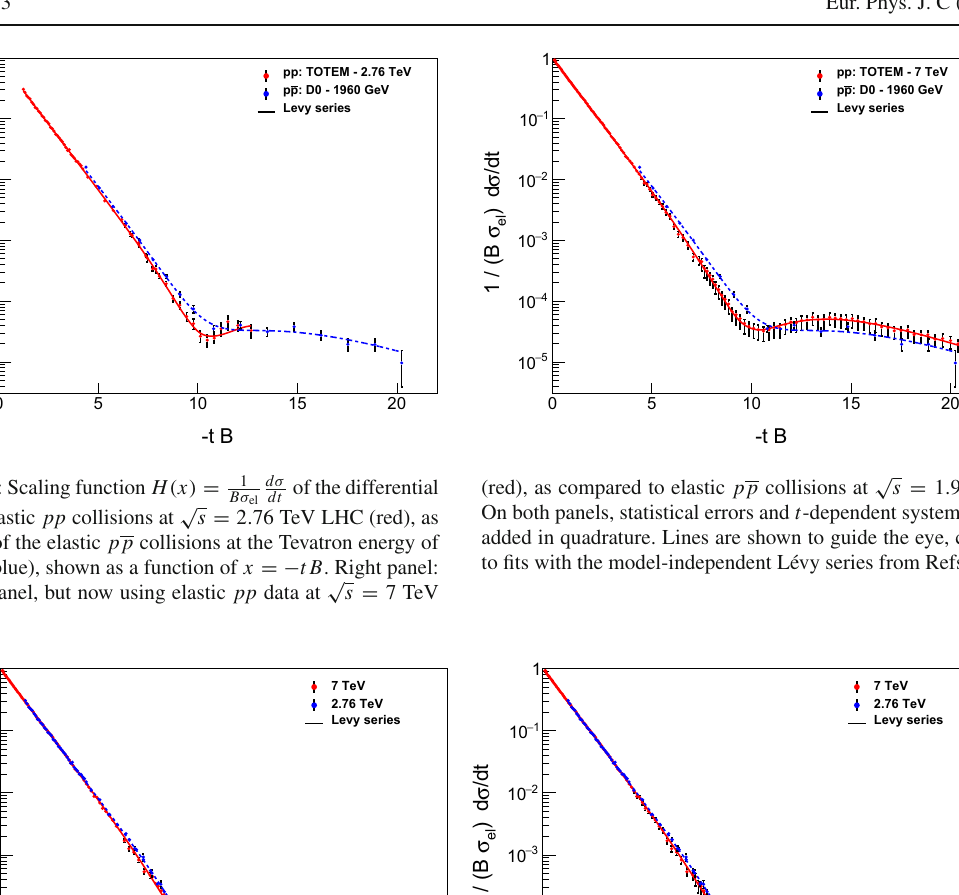
statistical errors only, while on the right panel, statistical errors and t -dependent systematic errors are added in quadrature. The two H ( x ) scaling functions are, within statistical errors, apparently the